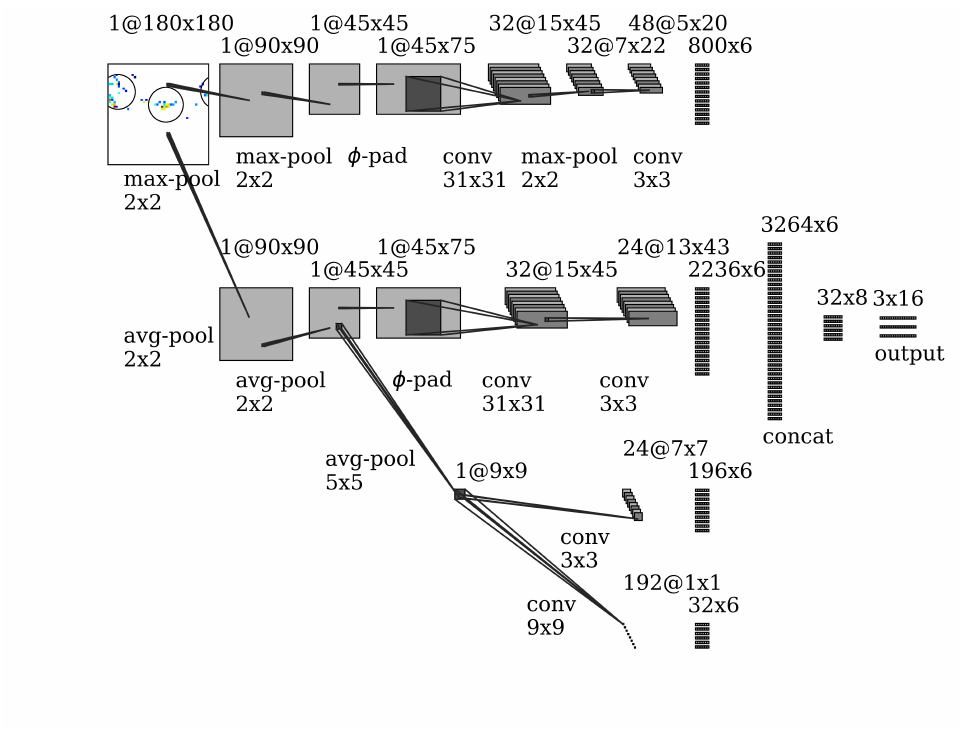
Figure 6: Pooling CapsNet architecture. The re-shaping of the final convolution re- sults into capsules with dimension i ≤ 6 is not